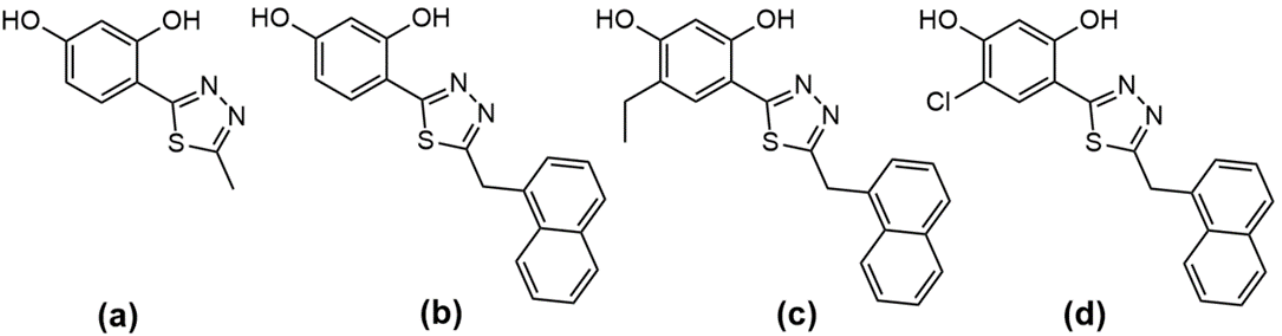
Figure 1. Structures of the investigated thiadiazole derivatives: C1 ( a ), NTBD ( b ); Et-NTBD ( c ), and Cl-NTBD ( d ).